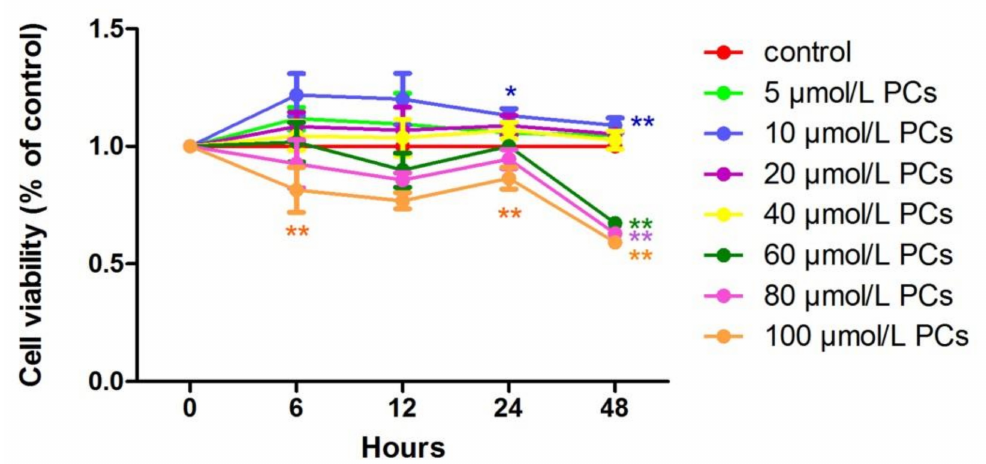
Figure 2. The effect of different of times and concentrations of proanthocyanidins ( PCs ) on the relative viability of BEND cells. * p < 0.05 vs. control group, ** p < 0.01 vs. control